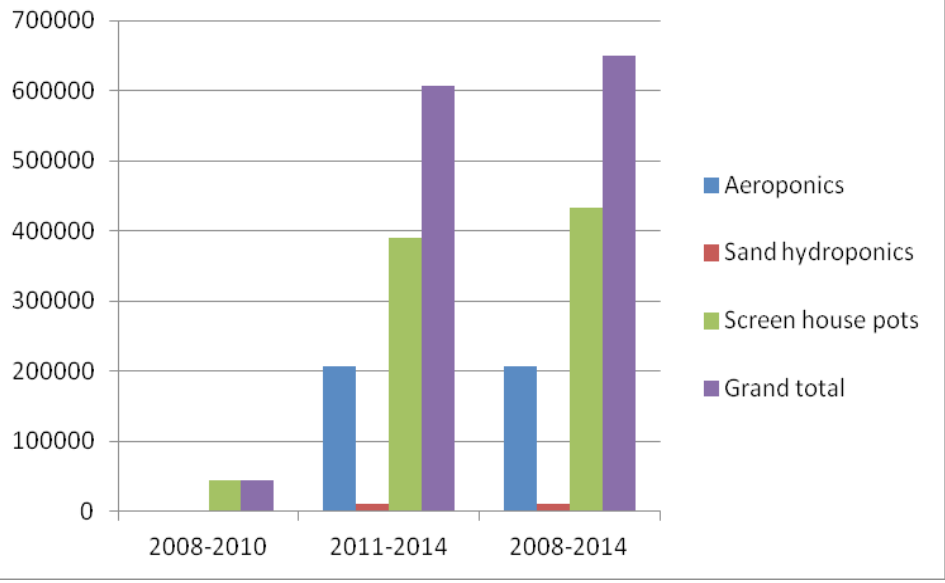
Figure 1: Mini-tuber production trends of Holetta Research Centre at screen house bases with aeroponics, sand hydroponics and